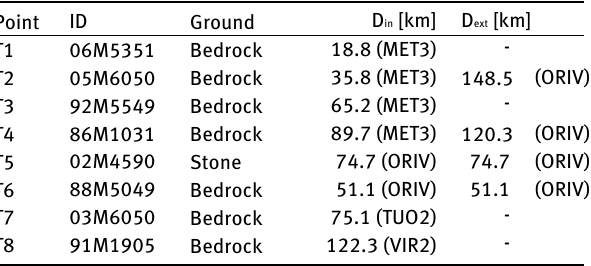
Table 1: Test points T1-T8. ID was given when a benchmark is origi- nally established. D in gives the distance to the closest FinnRef sta- tion when full network is utilized and D ext gives the value when test points are in the extrapolation area (see Fig. 2 and 3).